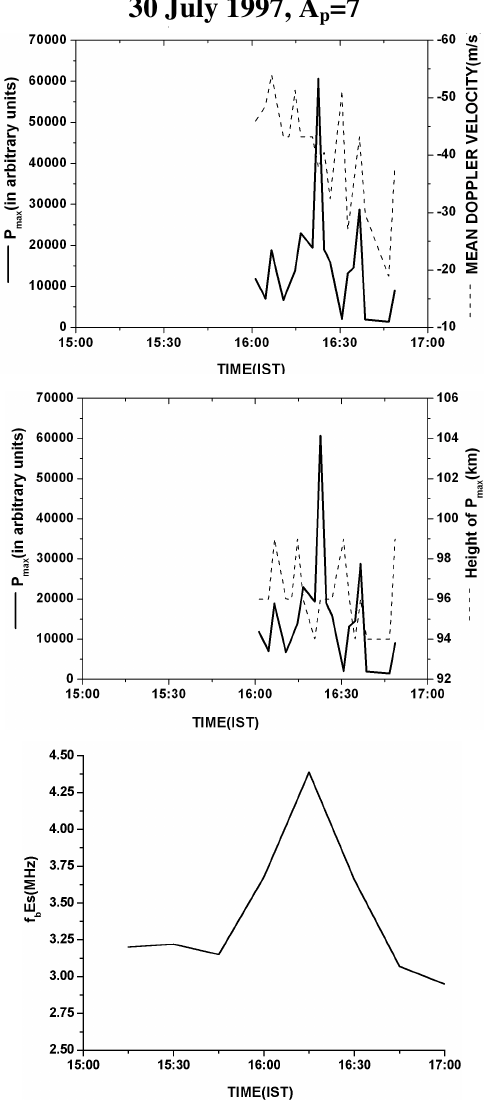
Fig. 9b. Time variation of the maximum backscattered power (P max ) and the corresponding Doppler velocity values (top panel) during the E sb event along with the variation of f b E s (bottom panel). Time variation of the maximum backscattered power (P max ) and the corresponding height of scattering region (middle panel) is also